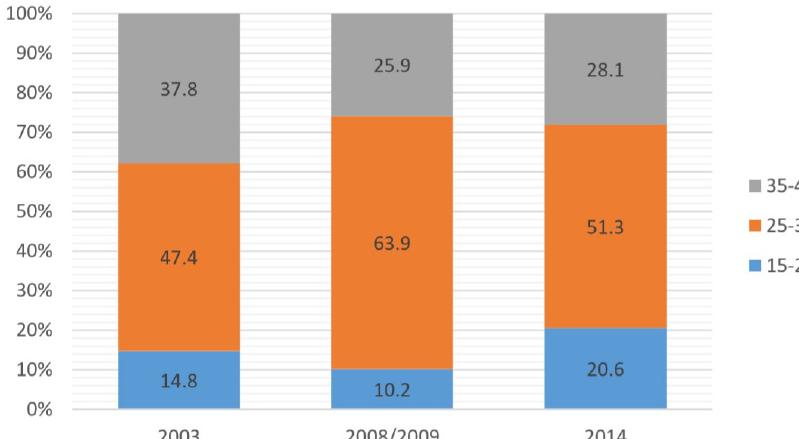
Figure 3. Implant use by age, 2003–2014.